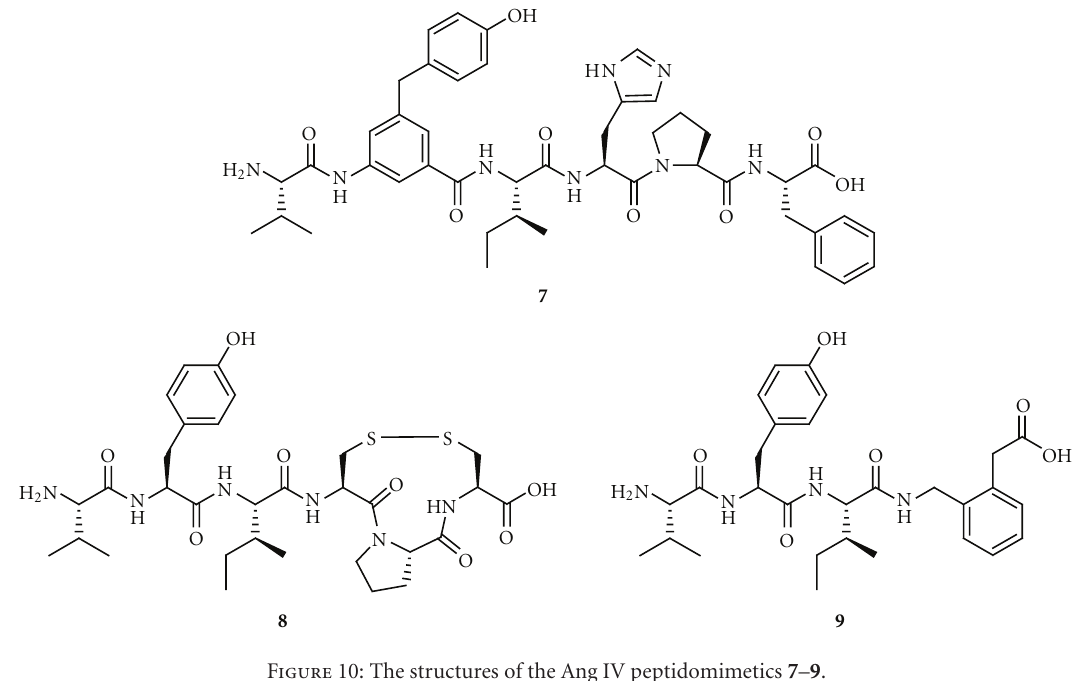
Figure 10: The structures of the Ang IV peptidomimetics 7 – 9 .